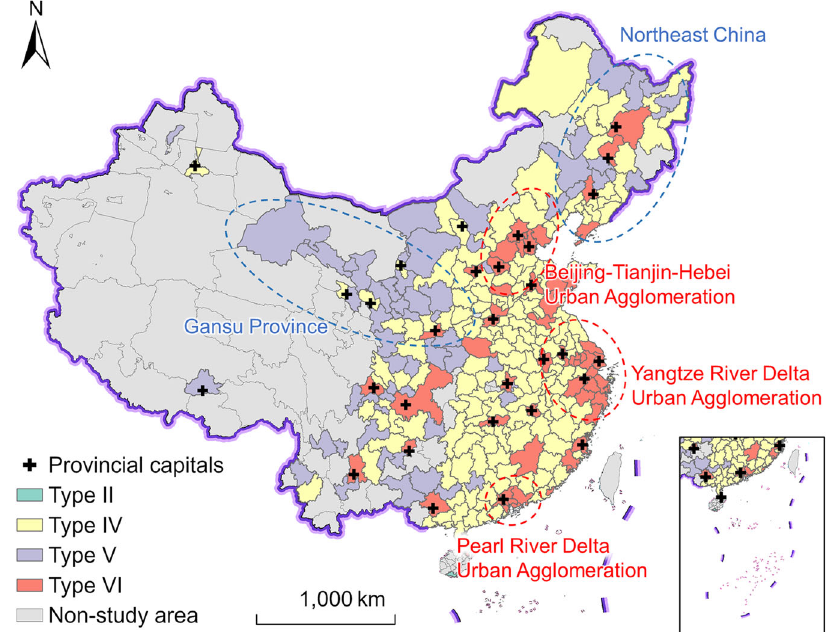
Fig. 8 The spatial distribution of PHS functional structure types. The fi gure shows the main characteristics of PHS functional structure types in different areas. The map was developed by the authors using ArcGIS Pro Version 3.0.2, and the background map was issued by the Ministry of Natural Resources of the People ’ s Republic of China (drawing review No. GS (2020) 4619), as shown in the website: